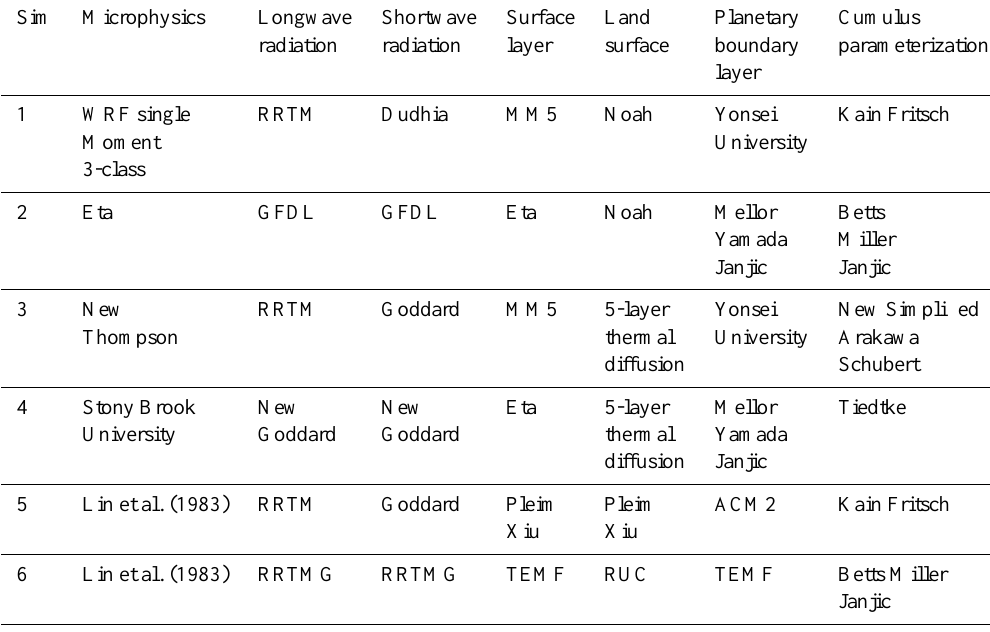
Fig1. Typhoon Noul trace in November (NOAA, 2008) 2 Figure 1. Typhoon Noul trace in November (NOAA, 2008). Table 1. Different simulations conducted in the study, using various combinations of schemes.